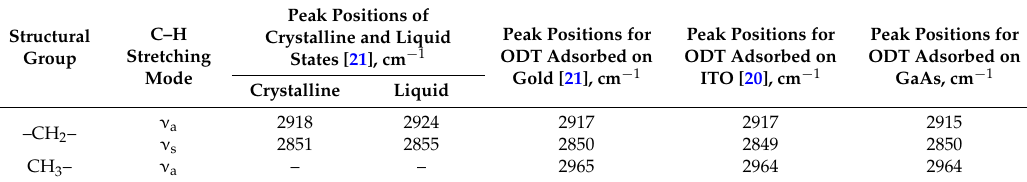
Table 1. Comparison of peak positions for ODT stretching modes in crystalline and liquid states, and SAMs on Au, ITO and GaAs.